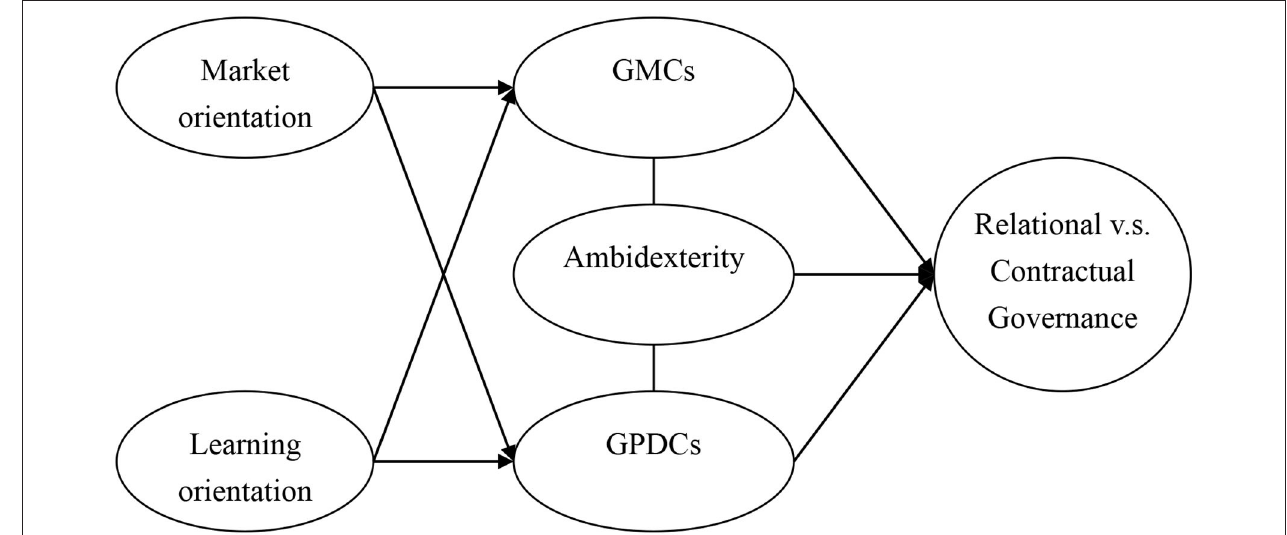
FIGURE 1 | Conceptual